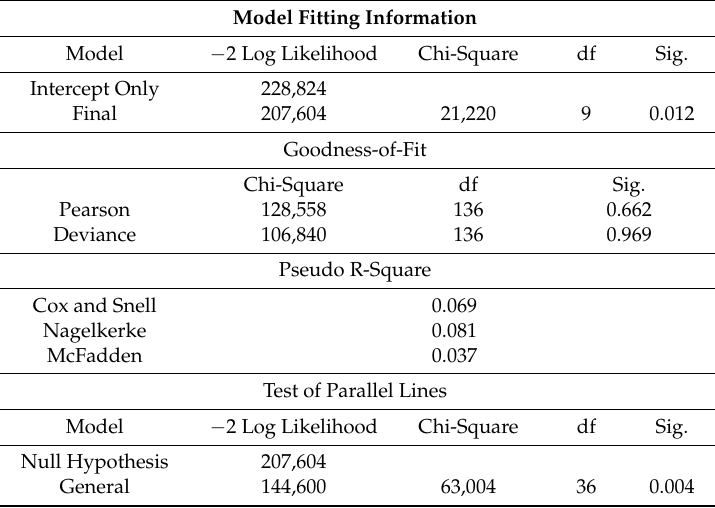
Table 3. Overall fitting indices for the bicycle